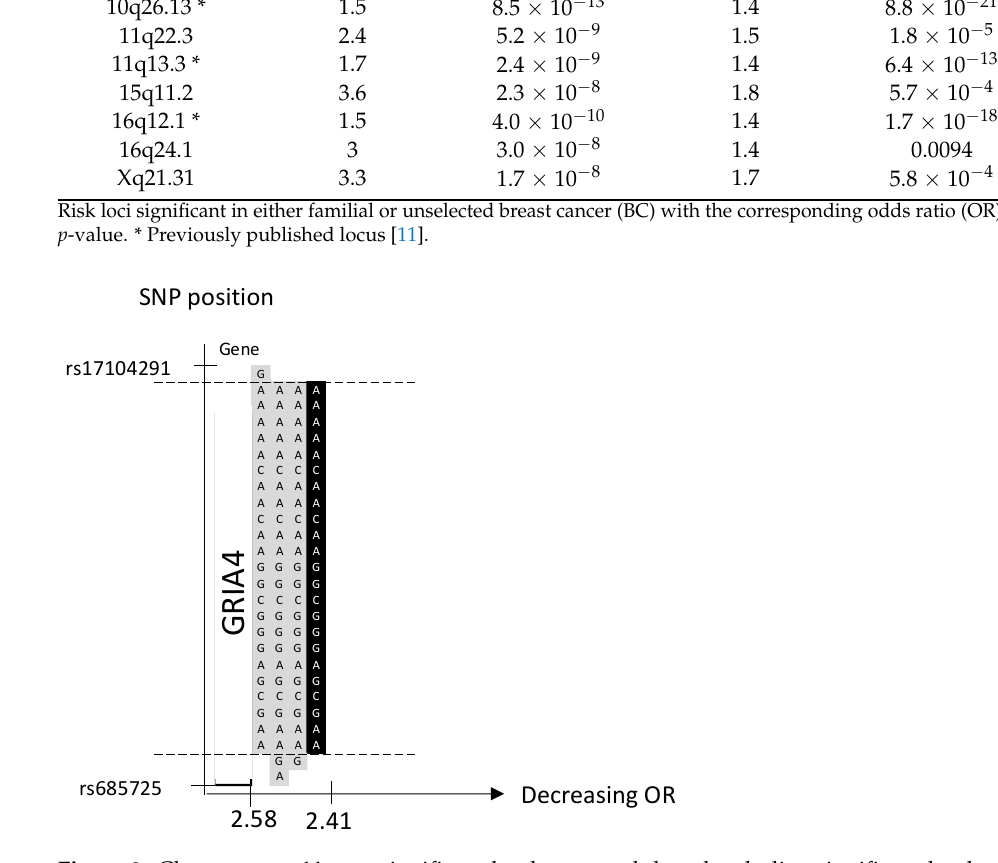
Figure 3. Chromosome 15, one significant and 22 borderline significant haplotypes sorted by OR . The significant haplotype is marked in black and borderline significant in light gray. SNP position is on the y -axis. The corresponding OR is on the x -axis. The dashed lines indicate the proximal and distal SNP that are shared by the significant and borderline significant haplotypes.